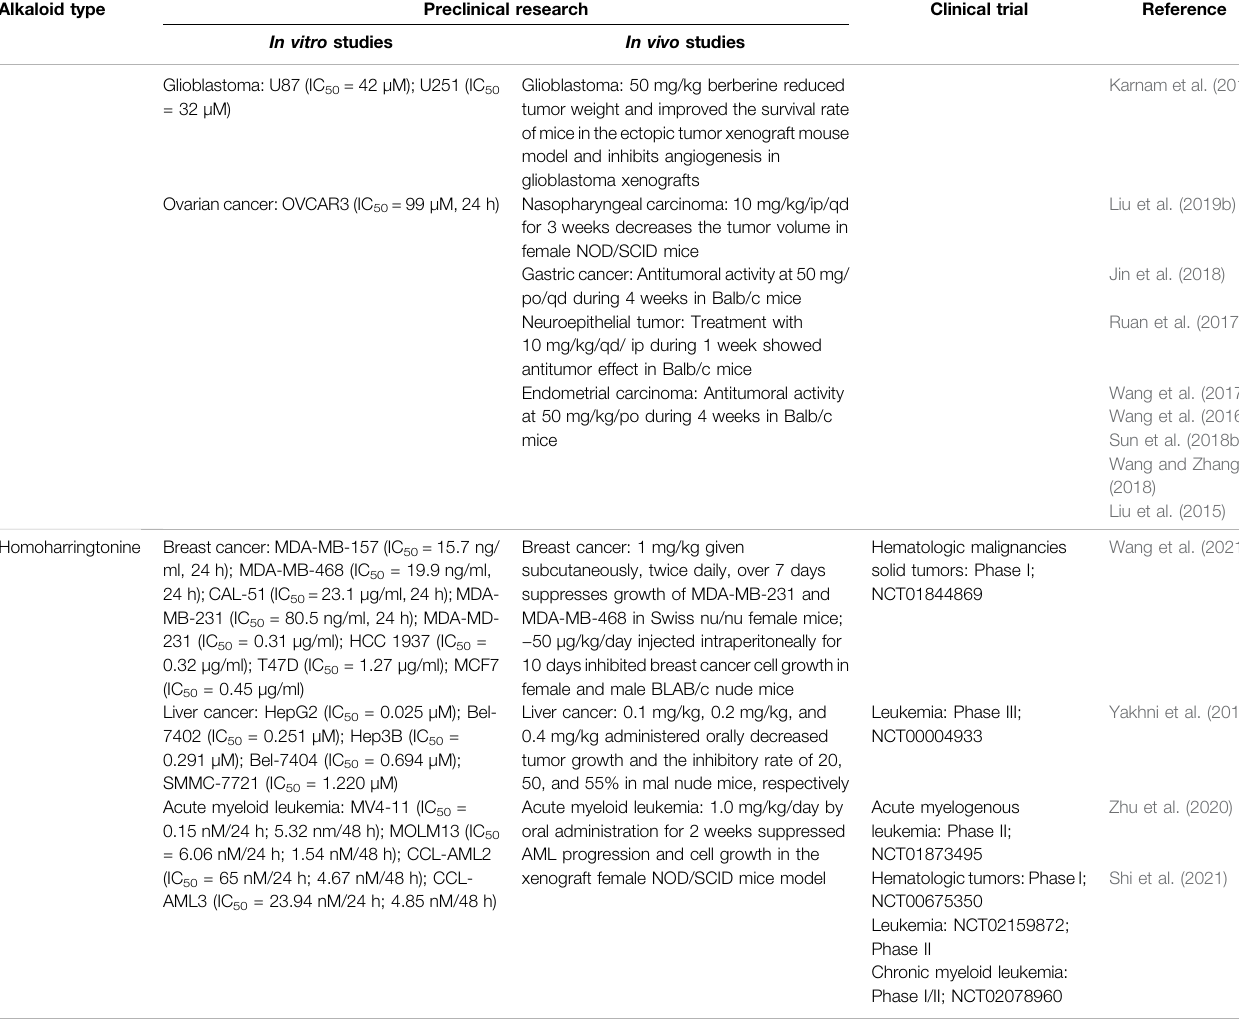
TABLE 2 | ( Continued ) Summary of recent preclinical and clinical trials of plant-based alkaloids on cancer